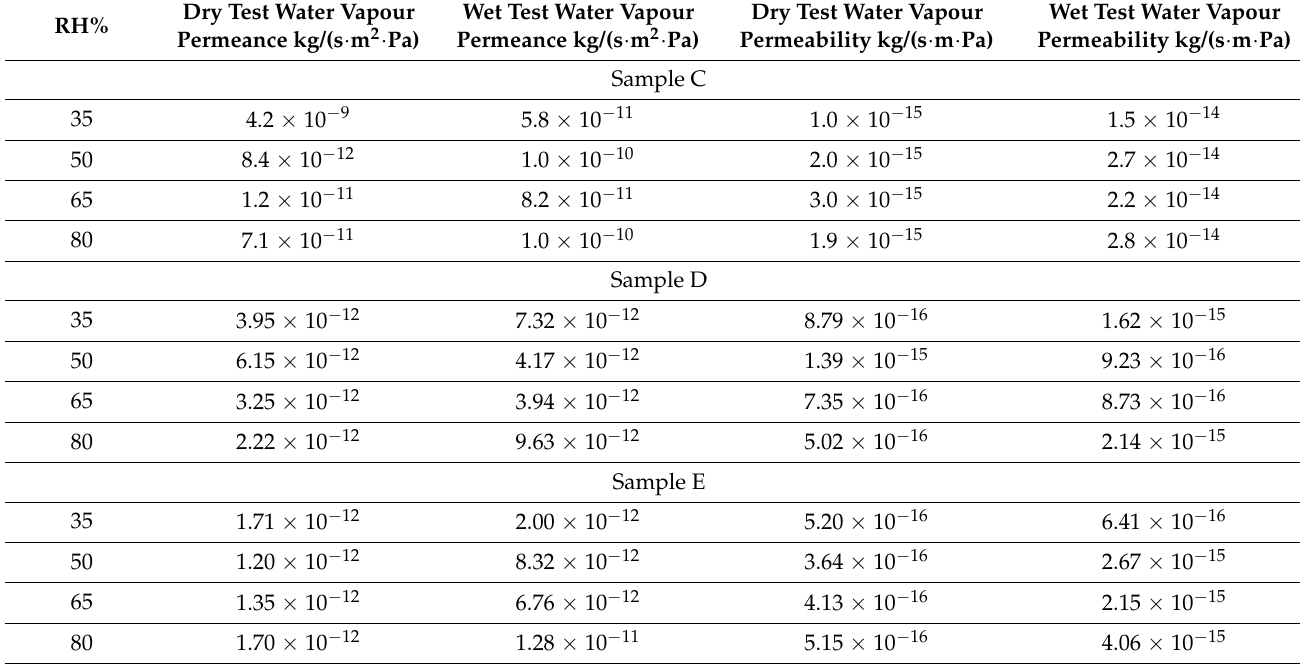
Table 3. Summary of average water vapour permeance and water vapour permeability of samples.